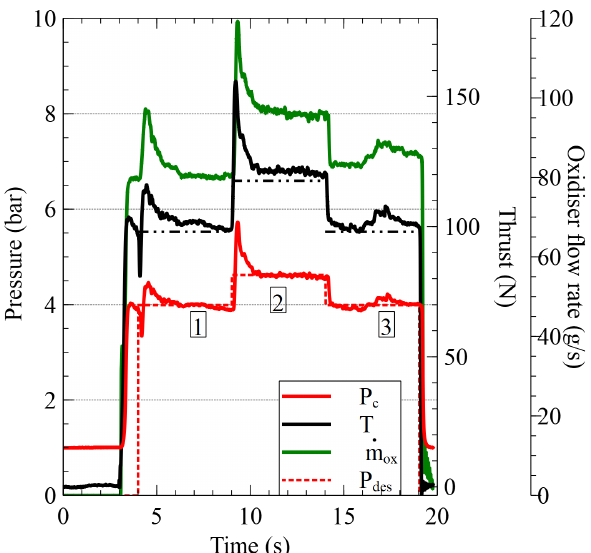
Figure 16. Throttling with active